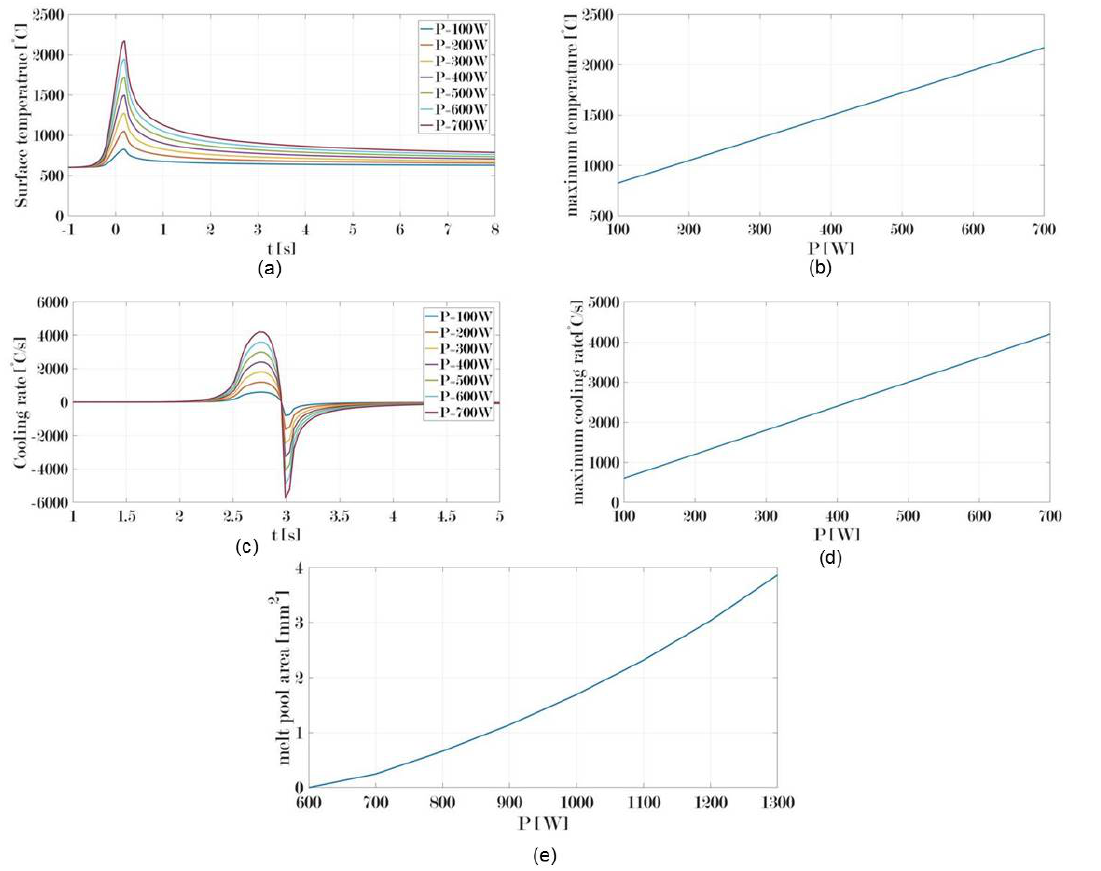
Figure 7. Simulation of the influence of the laser power on the temperature and on the melt pool ( V = 0.4 m/s) ( a ) surface temperature for different values of the laser power; ( b ) evolution of the maximum surface temperature with the laser power; ( c ) surface cooling rate for different values of the laser power; ( d ) evolution of the maximum surface cooling rate with the laser power; and ( e ) evolution of the melt pool cross section with the laser